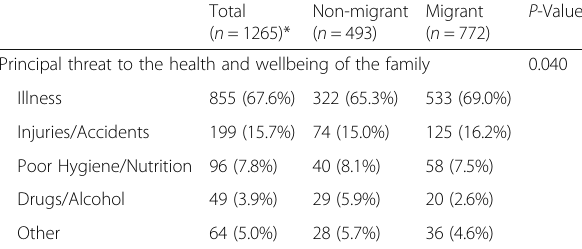
Table 5 Personal capital: Threats to health and wellbeing